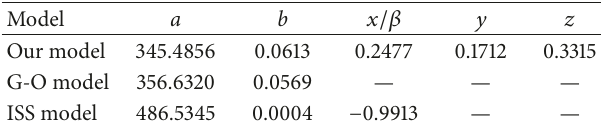
Figure 7: Fitted curve of ratio of critical faults to total accumulated faults. Table 1: Estimated parameters of the proposed model, G-O model, and inflection S-shaped model.